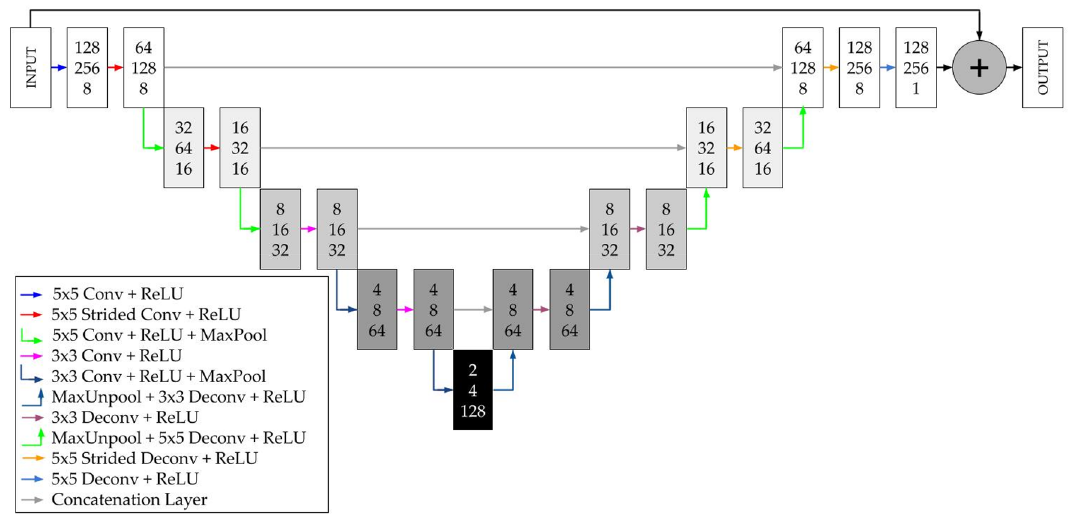
Figure 6. Schematic view of the proposed CNN for velocity and pressure field prediction.